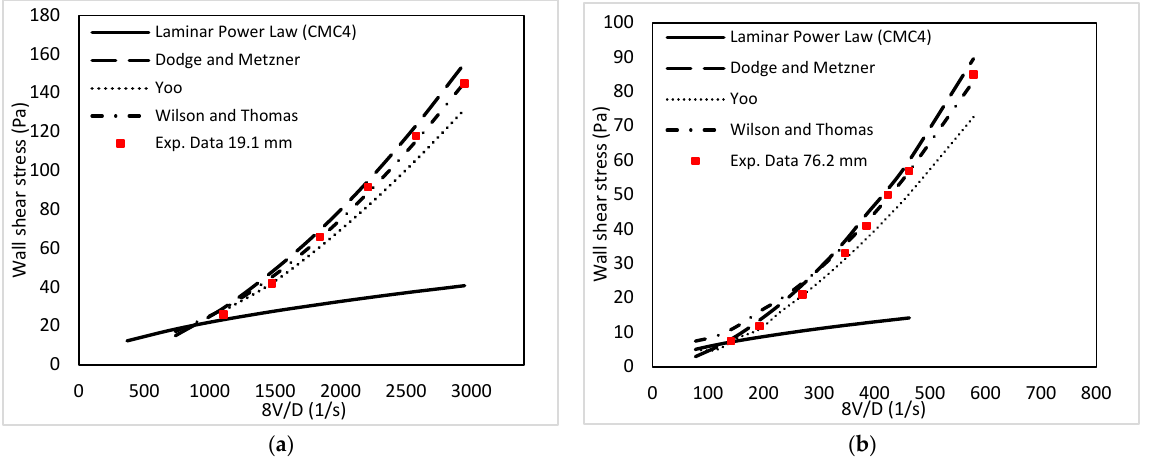
unsuccessful in predicting, and it exhibited the greatest variability and deviation from the experimental results. Binxin Wu [57] made similar observations.